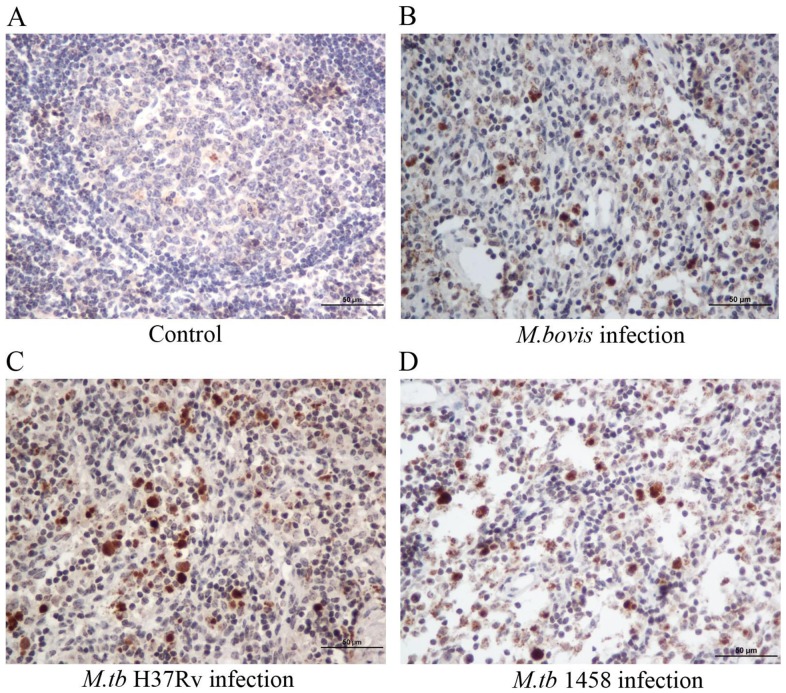
Histopathological observations of the tissues.An increase in neutrophil infiltration and lipofuscin-containing macrophages was observed in cattle lymph node tissue in groups infected with M. tbH37Rv, M. tb1458 of bovine origin, and M. bovis. The cells were stained with hematoxylin and eosin and observed via light microscopy. The black solid arrows indicate neutrophils and the double line arrow indicate lipofuscin-containing macrophages. Only B shows both cell types because it was difficult to find both co-existing in the same field.